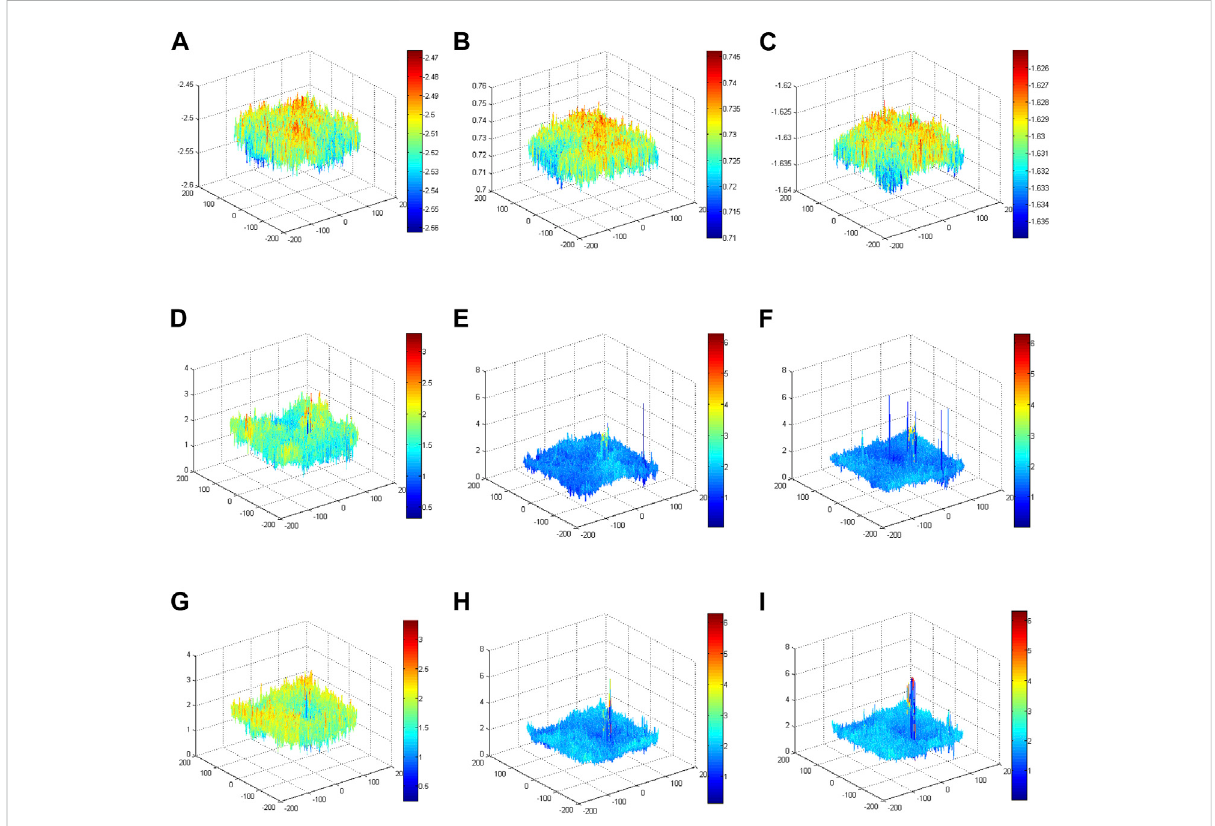
FIGURE 9 Phaseenergymapusingtheimproved GSalgorithm fordifferentmodels. (A) Phaseenergymapwith20iterations for Model 2. (B) Phase energy mapwith200iterationsforModel2. (C) Phaseenergymapwith2,000iterations forModel2. (D) Phaseenergymapwith20iterationsforModel3. (E) Phase energy map with 200 iterations for Model 3. (F) Phase energy map with 2,000 iterations for Model 3. (G) Phase energy map with 20 iterations for Model 4. (H) Phase energy map with 200 iterations for Model 4. (I) Phase energy map with 2,000 iterations for Model